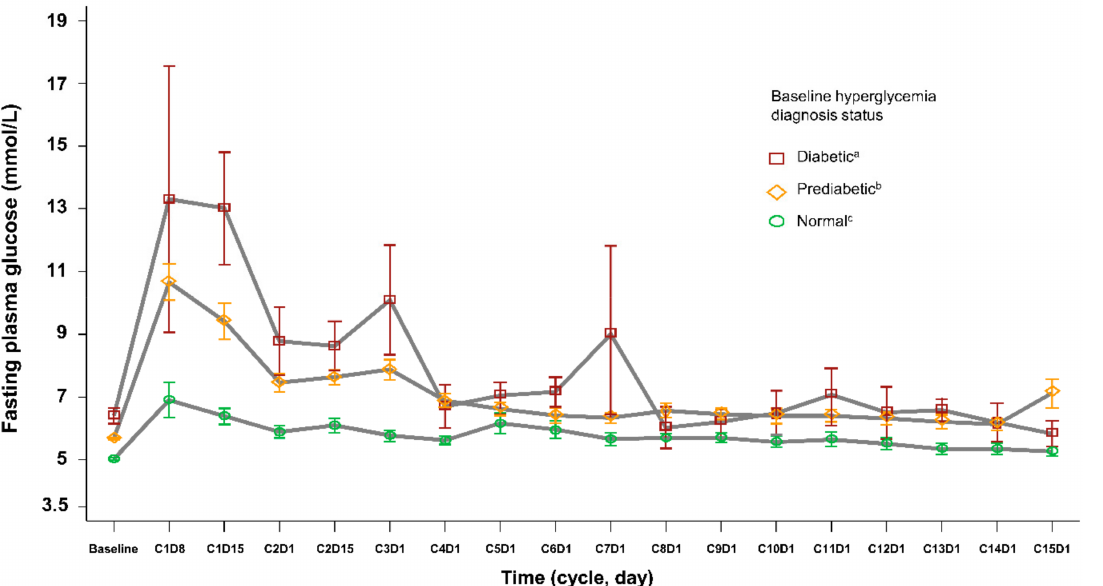
Figure 2. Changes in mean FPG over time according to glycemic status in patients with hormone receptor-positive breast cancer receiving alpelisib plus fulvestrant in the SOLAR-1 trial. Adapted with permission from Ref. [17], Copyright 2020 Elsevier. a FPG > 7.0 mmol/L (>126 mg/dL) and/or HbA1c > 6.5%; b FPG 5.6 to <7.0 mmol/L (100 to <126 mg/dL) and/or HbA1c 5.7 to <6.5%; c FPG < 5.6 mmol/L (<100 mg/dL) and HbA1c < 5.7%. FPG: fasting plasma glucose; HbA1c: glycated